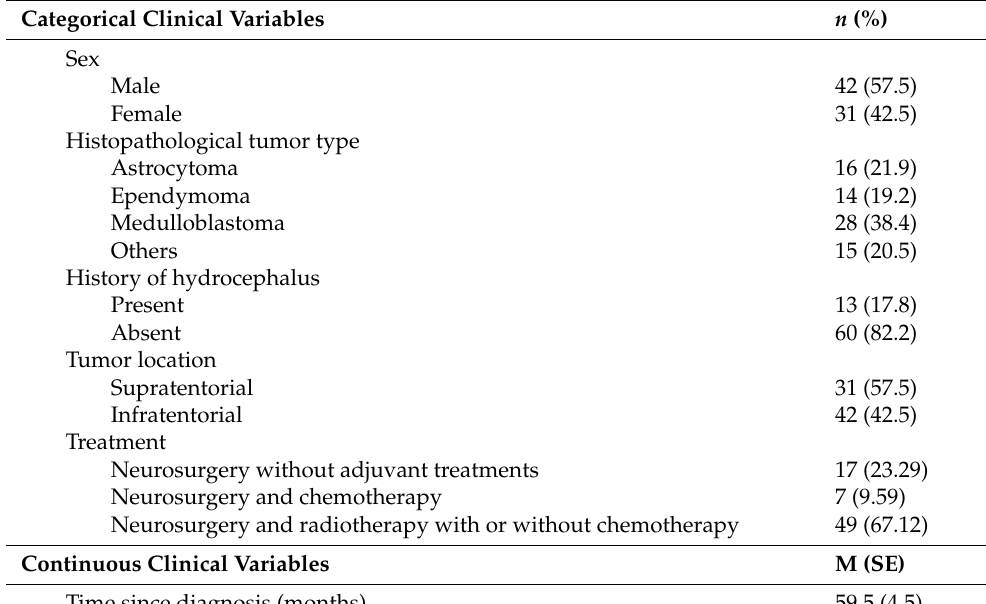
Table 1. Number ( n ) and percentage (%) or mean (M) and standard error (SE) of clinical variables of the final sample (k = 73) used for statistical